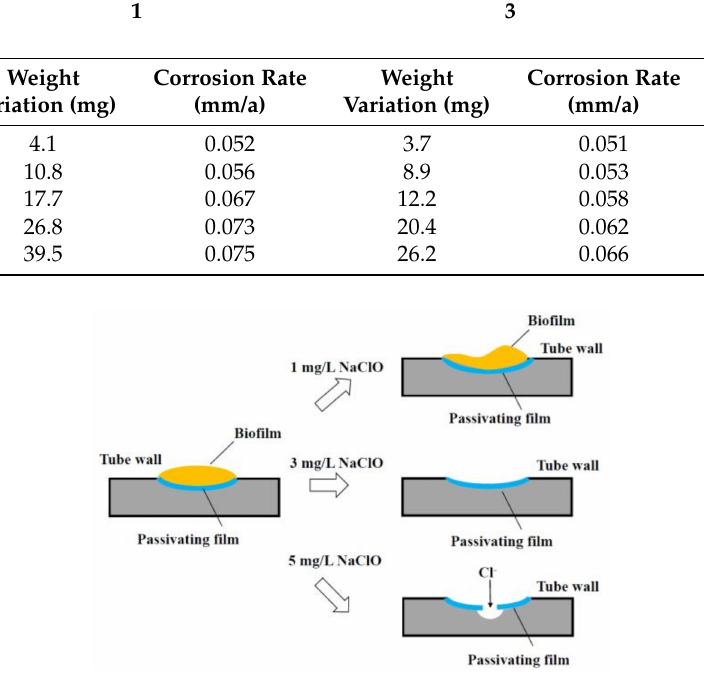
Figure 3. Schematical diagram of chlorine